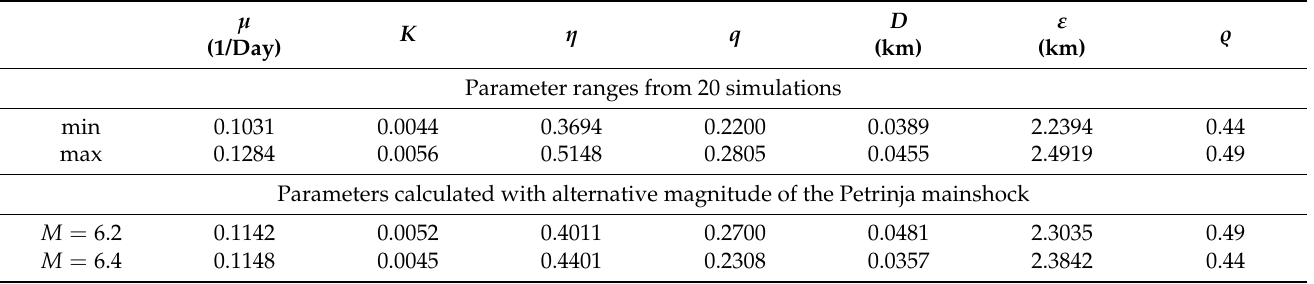
Table 2. Approximate error ranges for the estimated parameters and for the branching ratio (cid:36) .